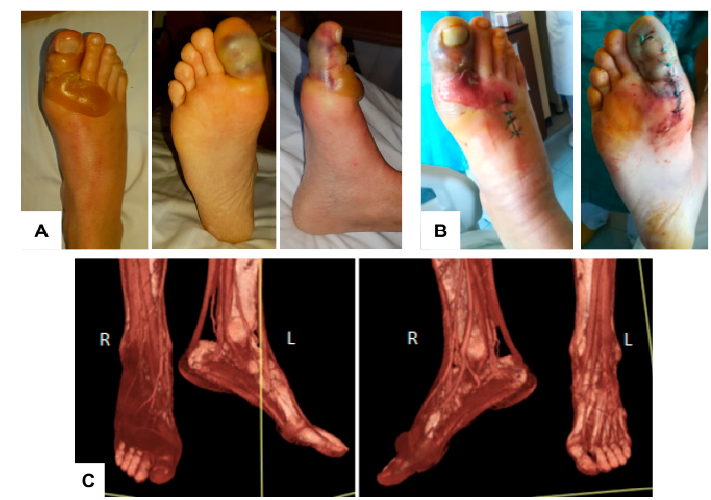
Figure 2. Clinical presentation of P. aeruginosa necrotizing fasciitis. ( A ) The small skin lesion rapidly evolved into blisters; ( B ) Appearance of the foot after open drainage attempt; ( C ) Computed tomography (CT) examination of the legs with volume rendering post-processing reformatted images showing the presence of pathologic tissue encasing the vessels, tendons, and muscles of the dorsal region of the right foot and ankle. Only the first toe is involved, while the others are spared.